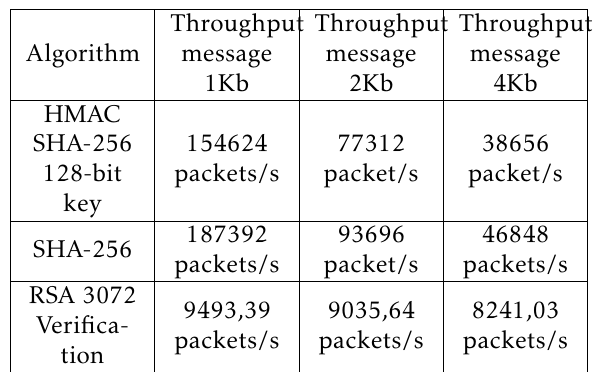
Table 2. The performance of local data authentication (without network